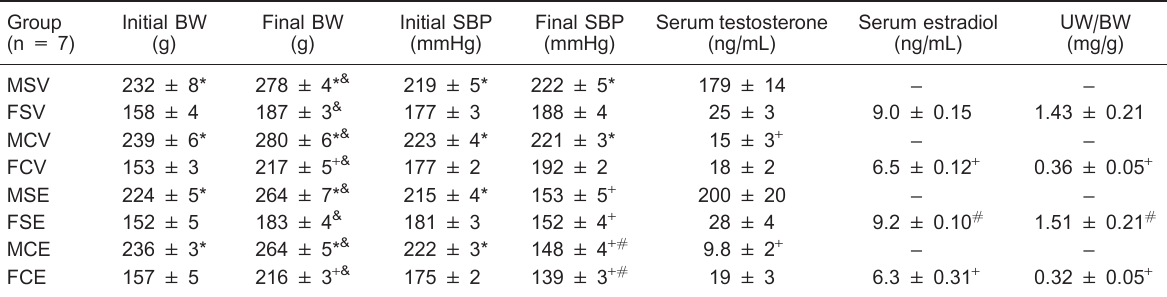
Figure 1. Plasma levels of angiotensin-converting exzyme (ACE) activity (arbitrary fluorescence units, AFU) in SV (sham + vehicle), SE (sham + enalapril), CV (castrated + vehicle), and CE (castrated + enalapril) groups. Data are reported as means ± SE. *P , 0.05 vs females of the same group; + P , 0.05 vs sham vehicle animals of the same sex; # P , 0.05 vs castrated animals of the same sex (two-way ANOVA and Fisher Table 1. Effect of castration and/or enalapril treatment on body weight (BW), systolic blood pressure (SBP), serum testosterone and estradiol, and uterine weight/body weight (UW/BW) ratio.